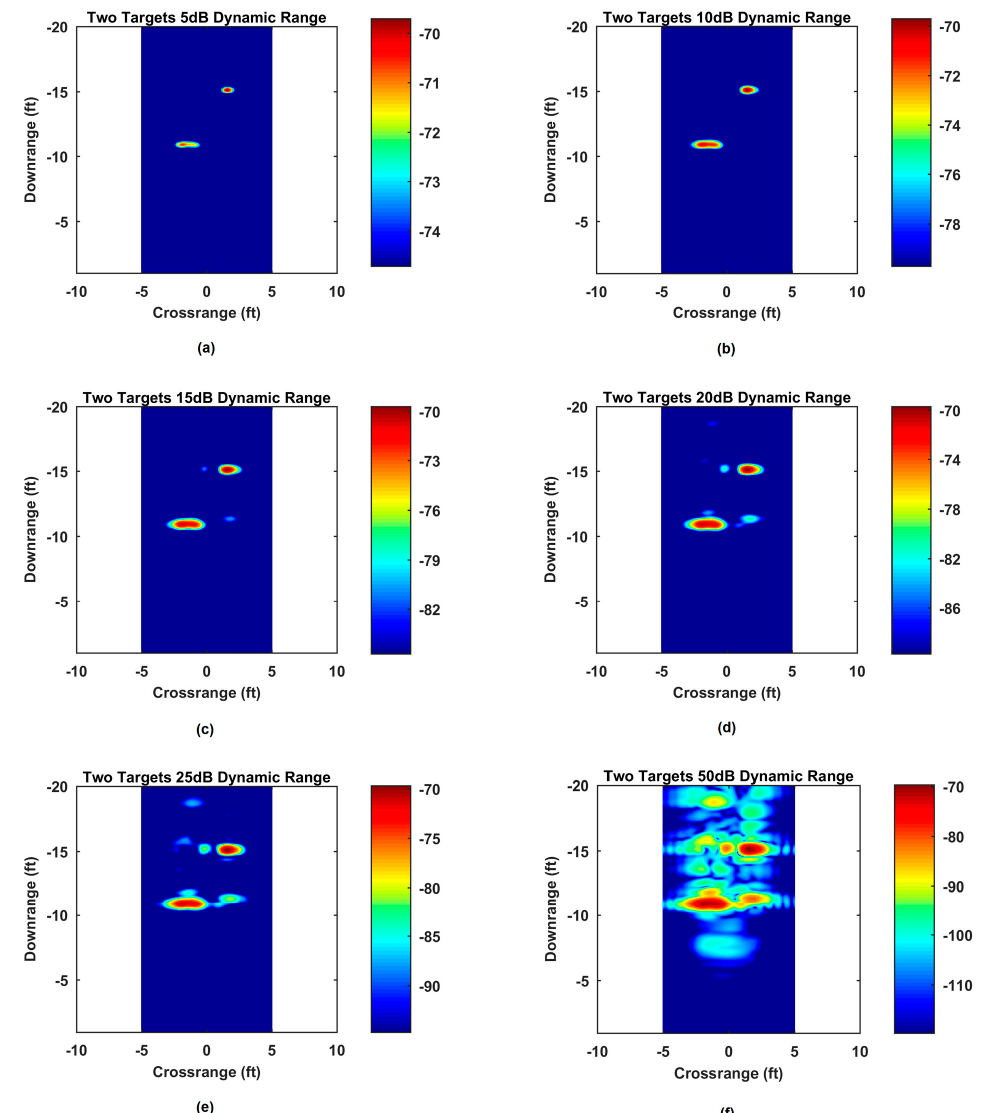
Figure 20. Images of a multiple targets at 3.35 m (11 feet) and 4.57 m (15 feet) down-range over 5–50 dB image dynamic range using wavelet-SVD: ( a ) 5 dB; ( b ) 10 dB; ( c ) 15 dB; ( d ) 20 dB; ( e ) 25 dB; ( f ) 50 dB.